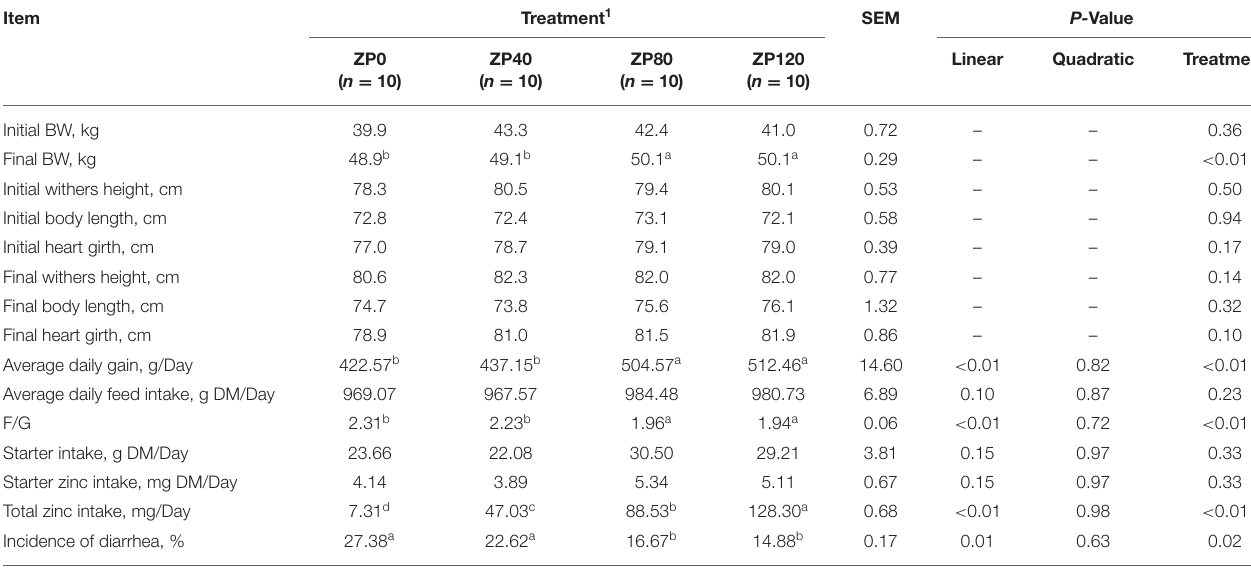
TABLE 2 | Effects of zinc proteinate (ZP) on the body size measurement, growth performance and incidence of diarrhea in dairy calves during the first 2 weeks of life (Experiment 1).